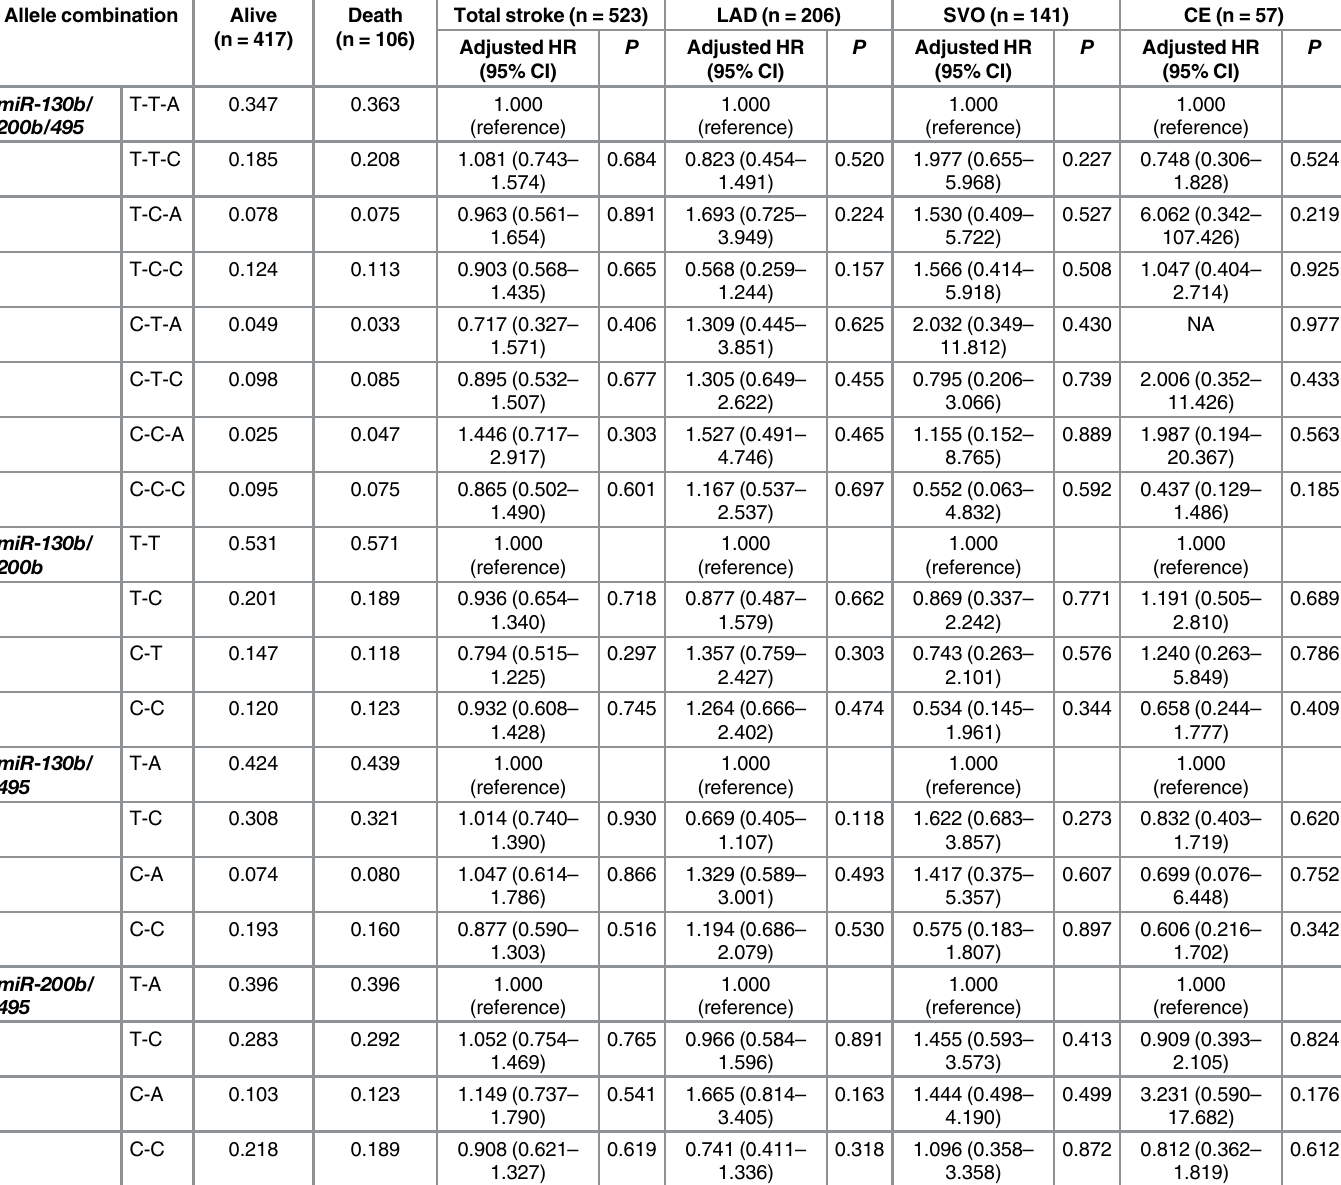
Table 7. Allele combination analysis for the association between microRNA polymorphisms and post-stroke mortality. Allele